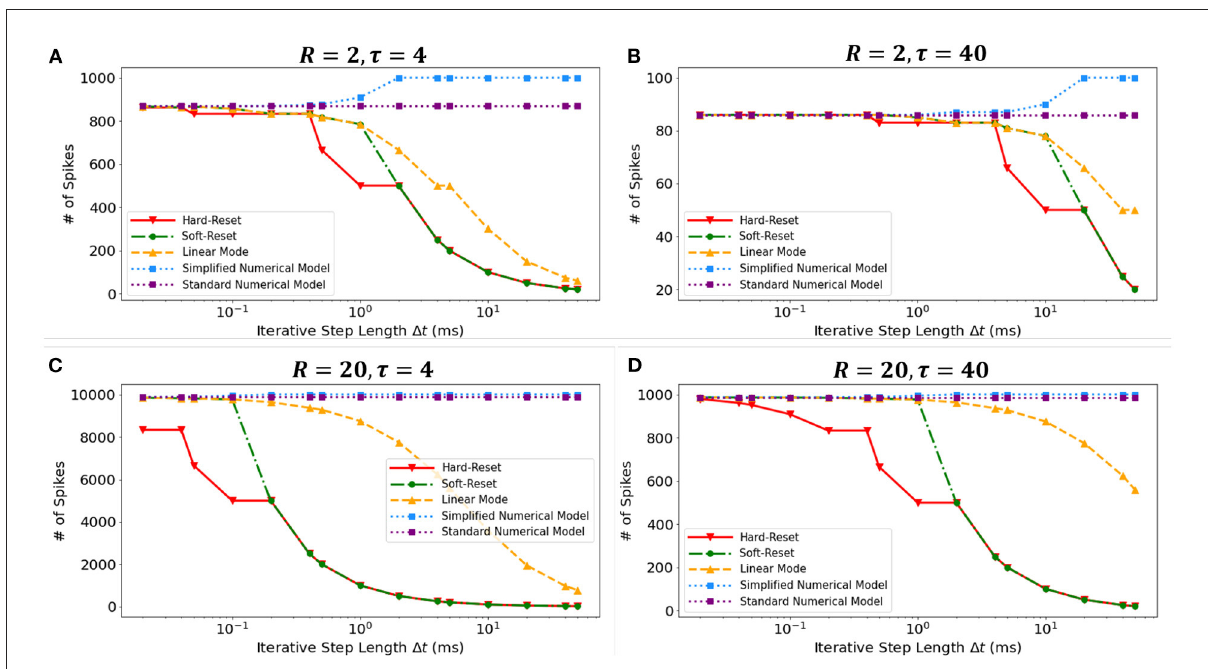
FIGURE7 The numbers of spikes via 1 t with different discrete models. Four experiments with different τ and R : (A) R = 2 (cid:127) , τ = 4 ms , (B) R = 2 (cid:127) , τ = 40 ms , (C) R = 20 (cid:127) , τ = 4 ms , (D) R = 20 (cid:127) , τ = 40 ms .